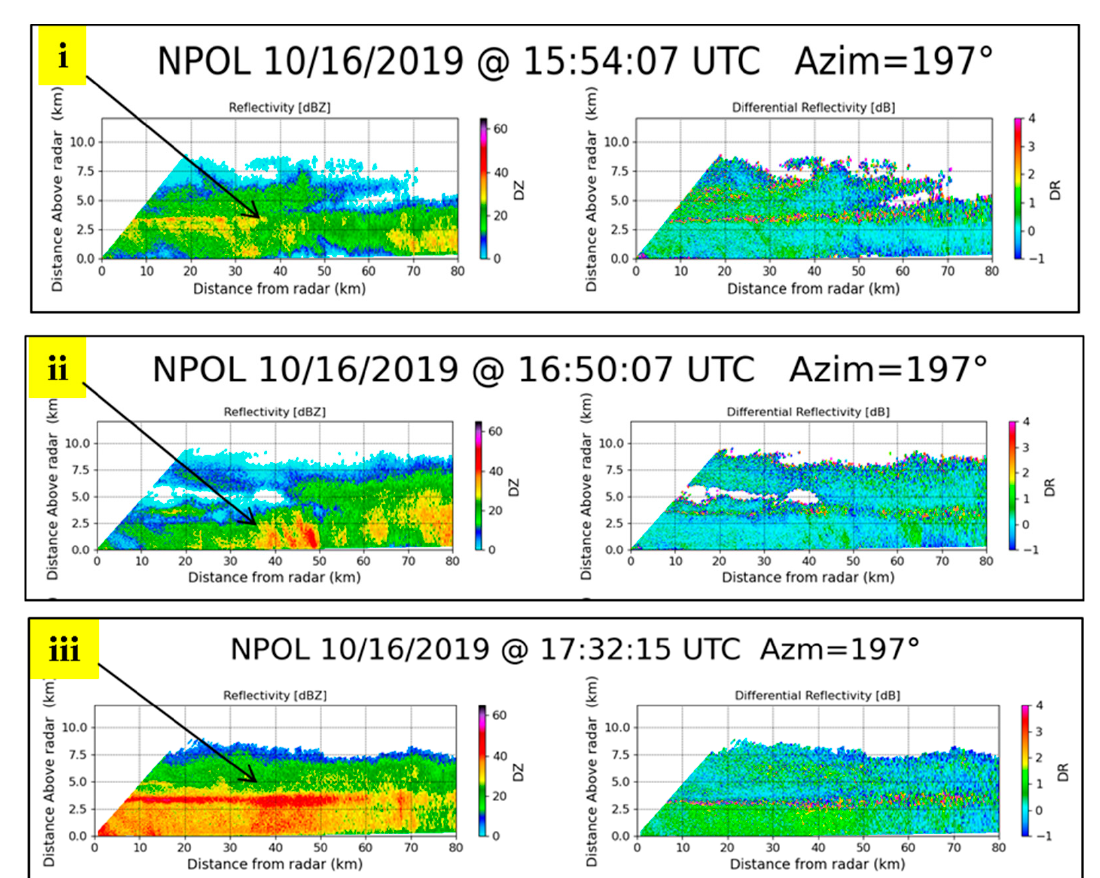
Figure 8. NPOL RHI scans of Z h and Z dr corresponding to cases (i)–(iii) in Figure 7. The arrows point to the vertical profiles above the location of the disdrometers.